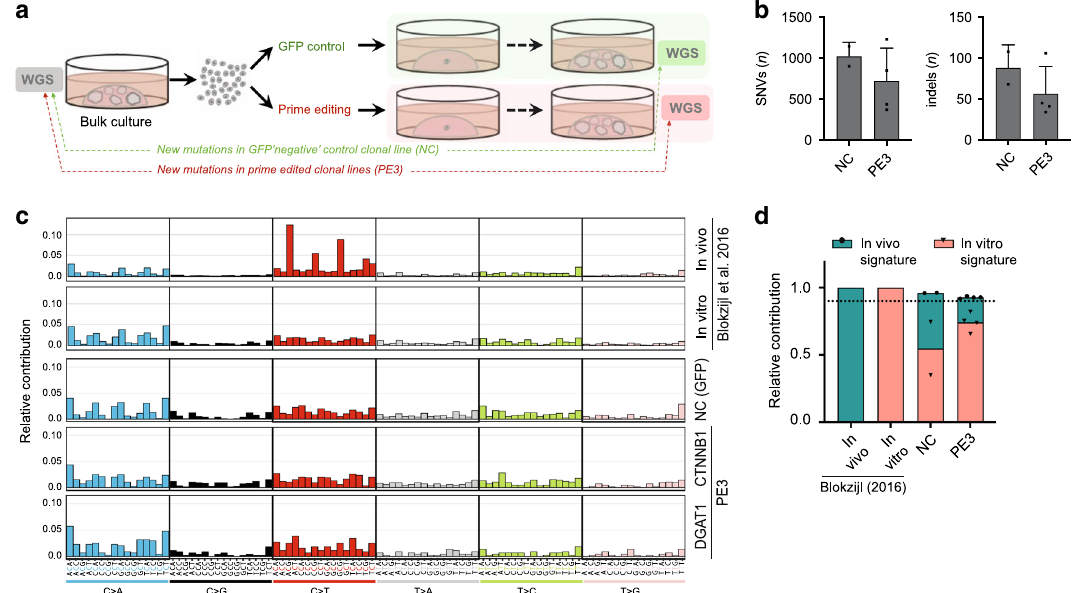
Fig. 3 Prime editing induces no genome-wide off-target effects. a Schematic overview of the protocol used to identify mutations induced by prime editing (PE3). WGS was performed for one unedited negative control and two prime-edited clonal lines for both DGAT1 (intestinal organoids) and CTNNB1 (liver organoids). b Total number of single-nucleotide variants (SNVs) and insertions and deletions (indels) in control (NC) and prime-edited (PE3) clonal organoid lines ( n = 2 and n = 4 biologically independent samples, respectively). Error bars represent S.D. c Mutational signature analysis by relative contribution of context-dependent mutation types in an in vivo ( n = 6) and in vitro ( n = 6) data set (Blokzijl et al. 16 ) and in control and prime-edited clonal organoid lines. d Relative contribution of known in vivo and in vitro mutational signatures from Blokzijl et al. 16 in control (NC) and prime-edited (PE3) clonal organoid lines ( n = 2 and n = 4 biologically independent samples, respectively). Dotted line at 0.9 indicates highly accurate signature reconstruction. NC negative control, WGS whole-genome